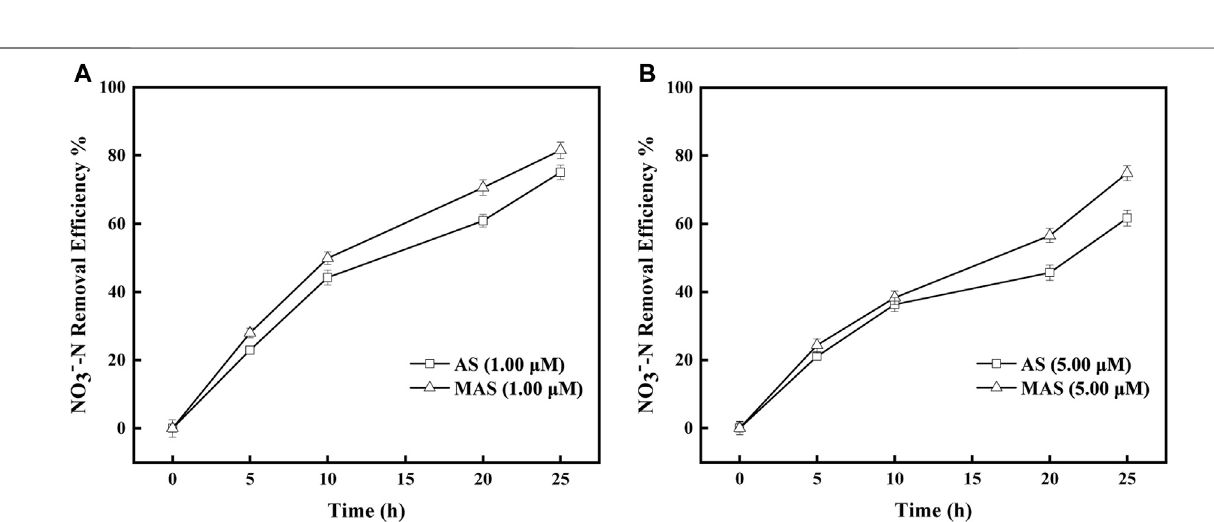
FIGURE 9 | Effect of nFe 3 O 4 on the sodium azide-inhibited respiratory chain in denitri fi cation. The concentrations of sodium azide were (A) 1.00 μ M and (B) 5.00 μ M, and NO 3 − -N was used as the fi nal electron